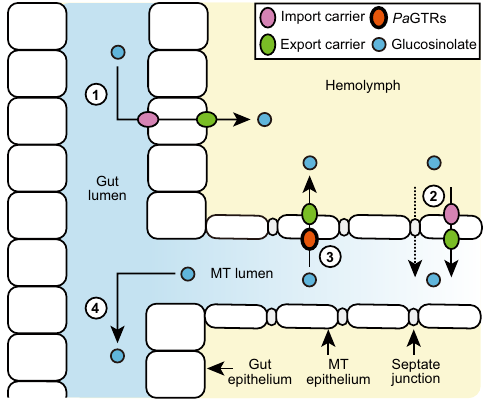
Fig. 5 Proposed model of glucosinolate sequestration in adult P. armoraciae . ① Absorption of ingested glucosinolates from the gut lumen into the hemolymph; ② transcellular or paracellular glucosinolate transport from the hemolymph into the Malpighian tubule (MT) lumen; ③ selective reabsorption of glucosinolates from the MT lumen into the hemolymph; and ④ excretion of excess glucosinolates. Pa GTRs localized in the MT are proposed to import glucosinolates from the lumen across the apical membrane into the epithelial